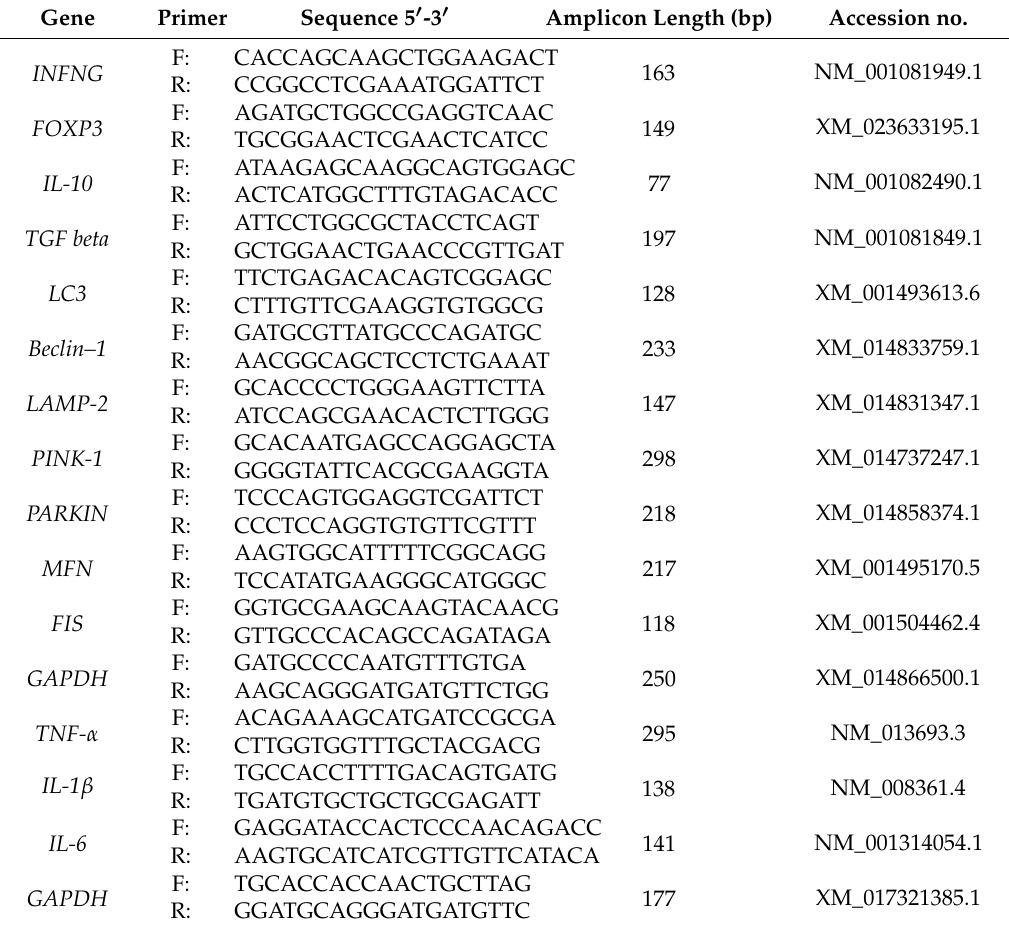
Table 1. Sequences of primers used in Reverse Transcription Polymerase Chain Reaction